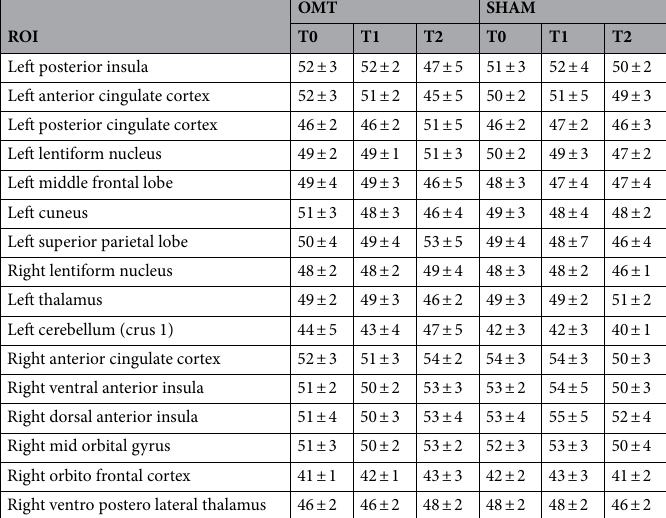
dorsal anterior insula (R-daINS) left anterior cingulate cortex (L-ACC), left superior parietal lobe (L-SPL) and the left middle frontal lobe (L-MFL, a subregion of the left frontal cortex), the left and right striatum, specifi- cally the lentiform nuclei (L-LN, R-LN), the left posterior cingulate cortex (L-PCC), the left cuneus (L-CU), left thalamus (L-THAL), right ventroposterior lateral thalamic nucleus (R-vplTHAL), right orbito-frontal cortex (R-OFC), right anterior cingulate cortex (R-ACC), right mid orbital frontal gyrus (R-MOFG) and the left cer- ebellum crus 1 (L-Cereb(CrI)). Considering the region of interest (ROI) analysis, the mixed effect regression (MER) analysis showed that, as compared with control group, patients that received OMT demonstrated decreased regional CBF in the L-pINS, L-ACC, L-MFL, L-THAL and the L-CU (Fig. 2 and Table S1). Conversely, rCBF was increased in the L-LN, R-LN, L-PCC, L-SPL, R-vaINS, R-daINS, R-vplTHAL, R-OFC, R-ACC, R-MOFG and L-Cereb (CrI) in OMT patients as compared with controls (Table S1, Fig. 2 and Figure S2). Post-hoc analysis revealed that these changes were statistically significant only at T2 and not immediately